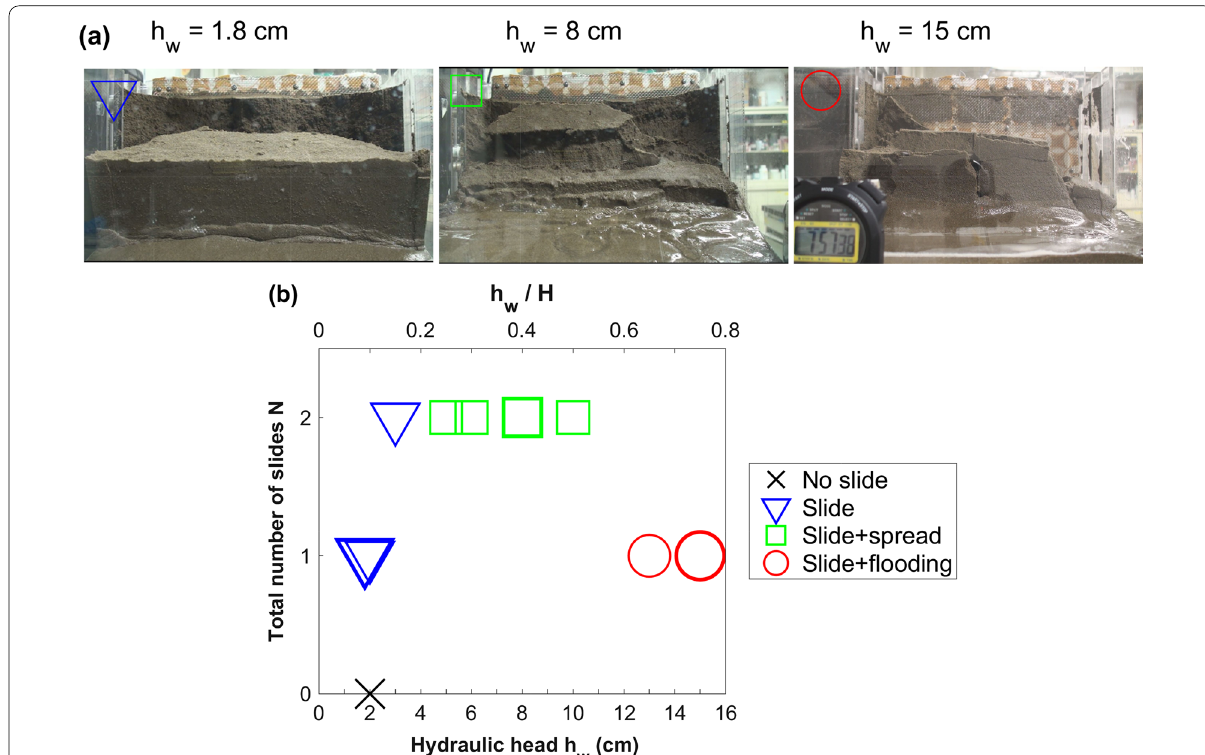
Fig. 3 Hydraulic head h w dependence of the styles (in marker shapes) and the total number N of the slides of the H ≃ 20 cm, L = 13.5 cm cliffs. a Front views of the landslides at their final stages for three different h w values. The cliff width is W = 35 cm. Left: the h w = 1.8 cm (run 13, / H = 0.09 , Additional file 1: Movie S1) case at t = 2940 s after a slide is triggered. Center: the h h w Movie S2) case at t = 900 s after 2 slides are triggered, followed by a spread. The lower (upper) terrace formed after the second (first) slide. Right: the = 15 cm (run 7, h / H = 0.75 ) case at t = 180 s after a slide is triggered, followed by flooding. b N versus h h w w with N = 0 ). The upper horizontal axis is in the h w / H scale. The 3 large markers correspond to the runs shown in